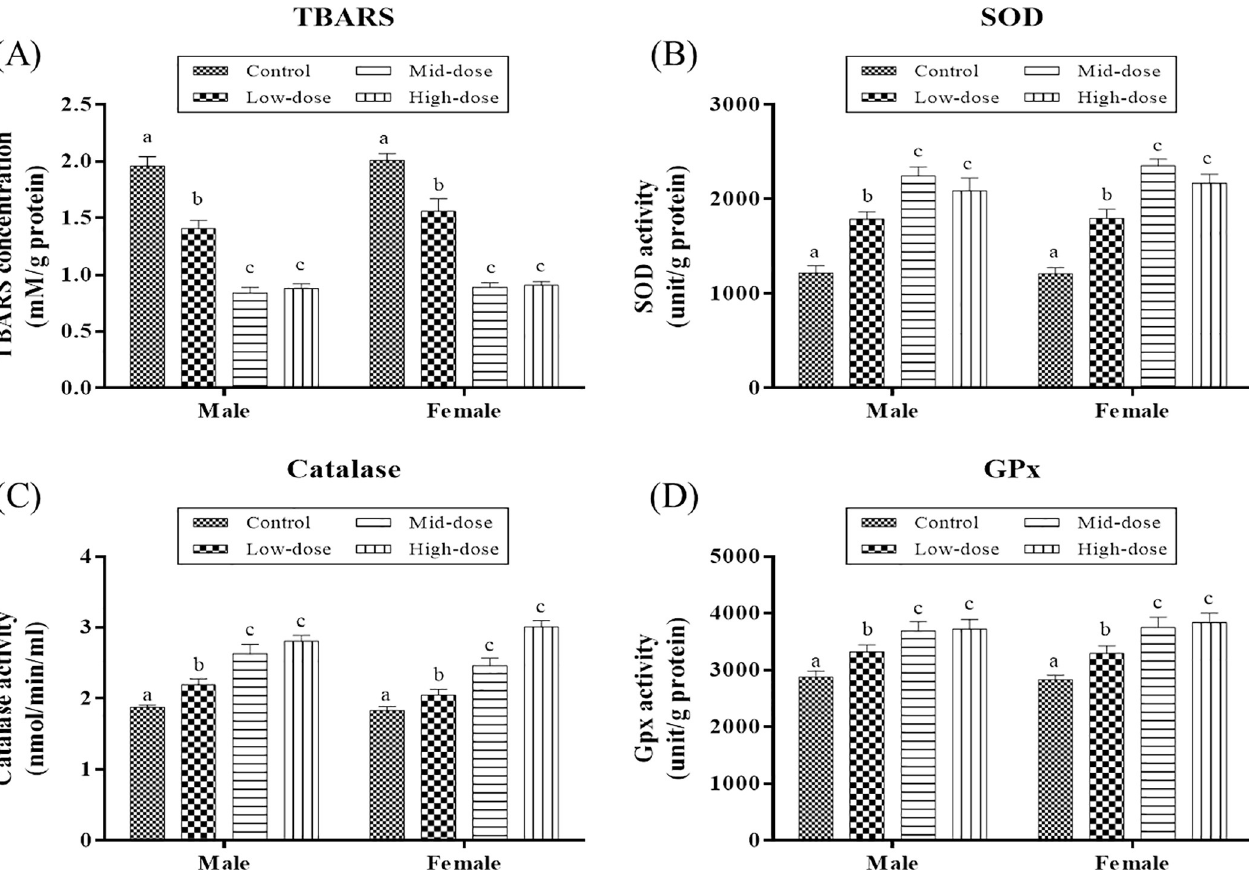
Fig 3. Effect of 13 weeks of erinacine A-enriched H . erinaceus mycelia on the activities of (A) thiobarbituric acid reactive substances (TBARS), (B) superoxide dismutase (SOD), (C) catalase, and (D) glutathione peroxidase (GPx) in the liver of SAMP8 mice (n = 80). Different letters indicate significant differences in the mean